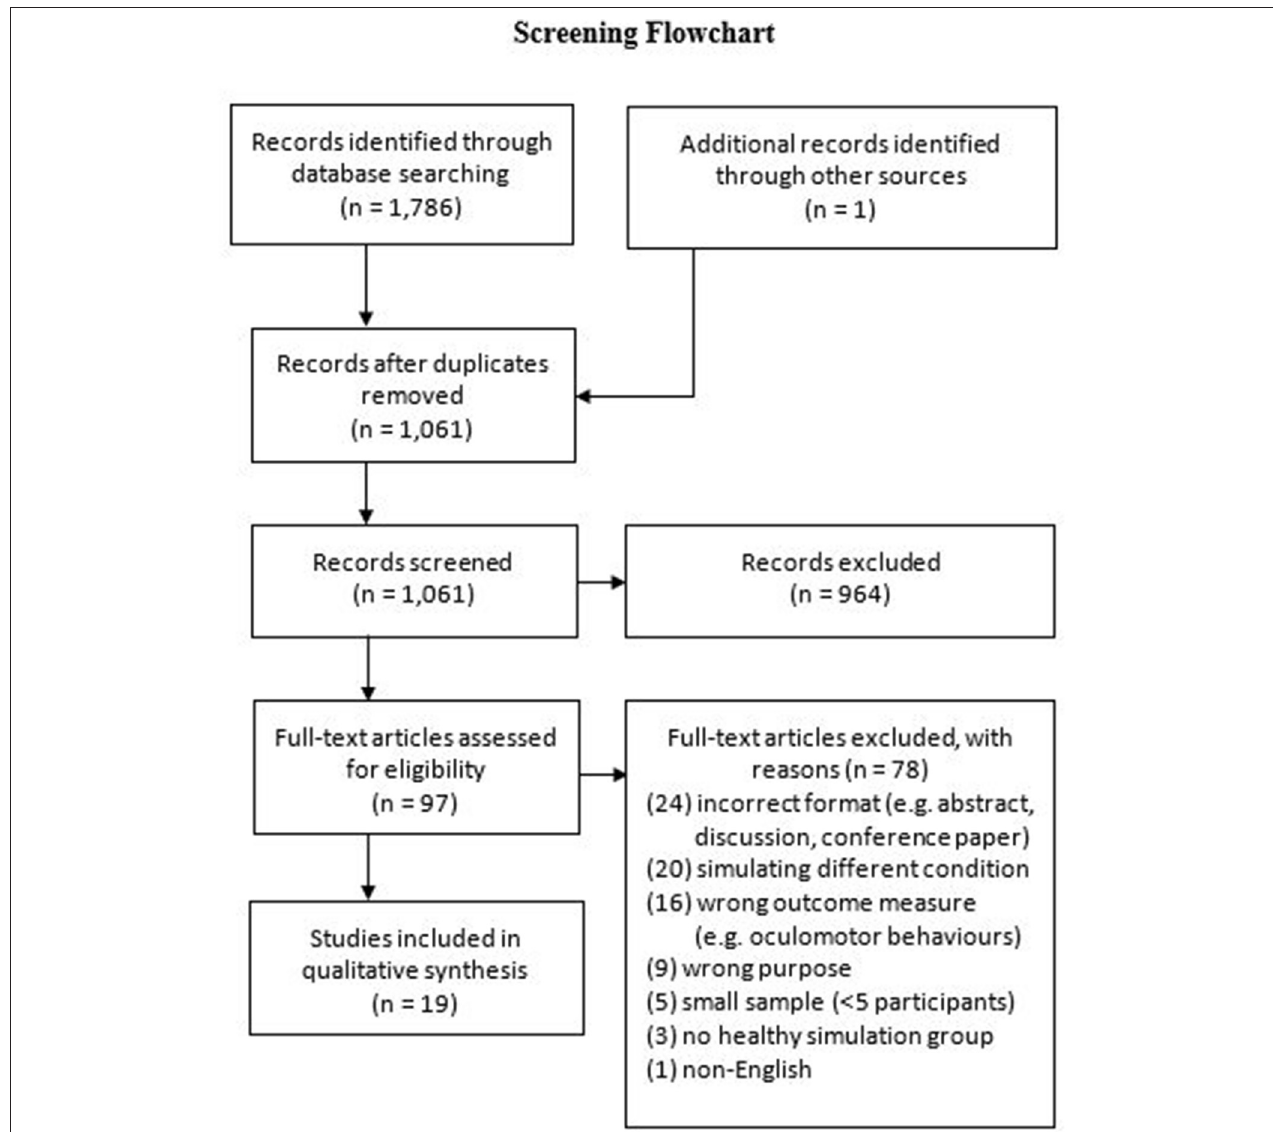
FIGURE 1 | Screening flowchart for studies simulating age-related macular